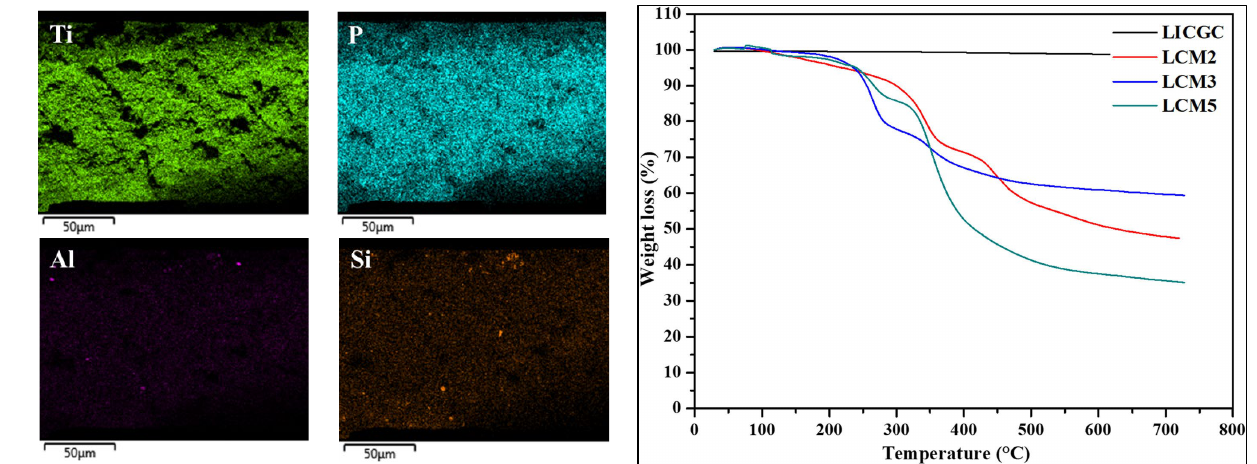
Figure 1. SEM surface and cross section of LCM5, EDX mapping images of LCM2 cross section and TGA curves of some prepared membranes. Adapted from [75].